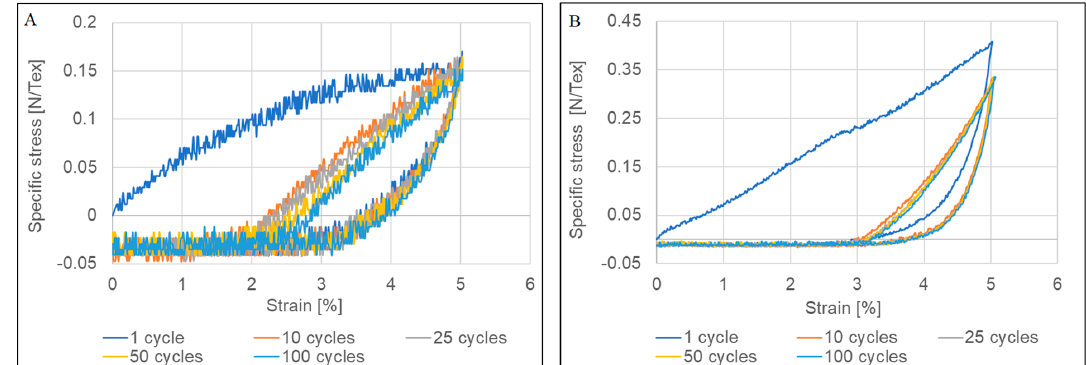
Figure 5. Tensile properties of ( A ) untreated CNTYs and ( B ) post ‐ treated CNTYs under cyclic loading; 100 stretching/relaxing cycles were conducted to a constant 5% strain.